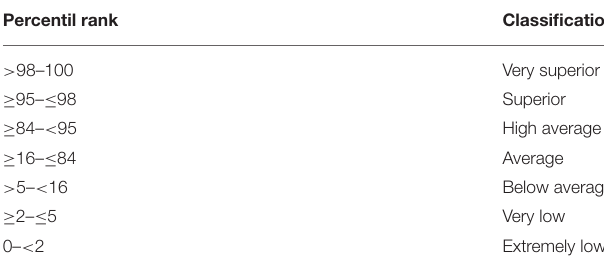
TABLE 2 | Categorical classification of percentile rank (PR) values according to the German Guidelines (www.neuropsy.ch; category descriptors translated by the